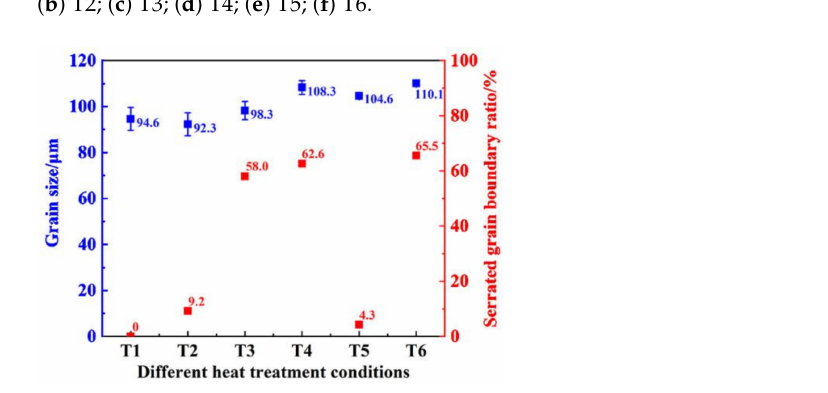
Figure 4. Typical microstructure of GH4975 alloy under different heat treatment conditions: ( a ) T1;